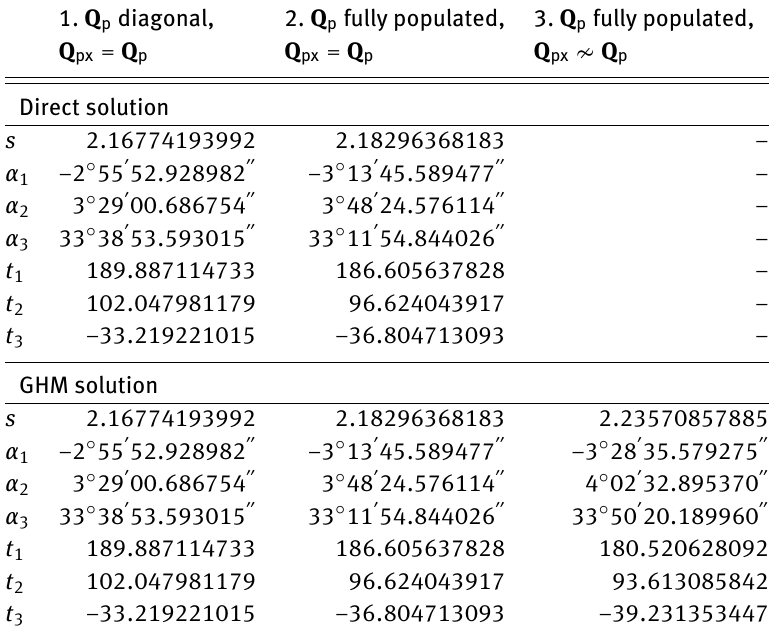
Table 2: Example of a 3D similarity transformation: adjusted parameters; Q py = k y Q p with k y = 2.25 applies to cases 1–3; in case 3 the direct solution is